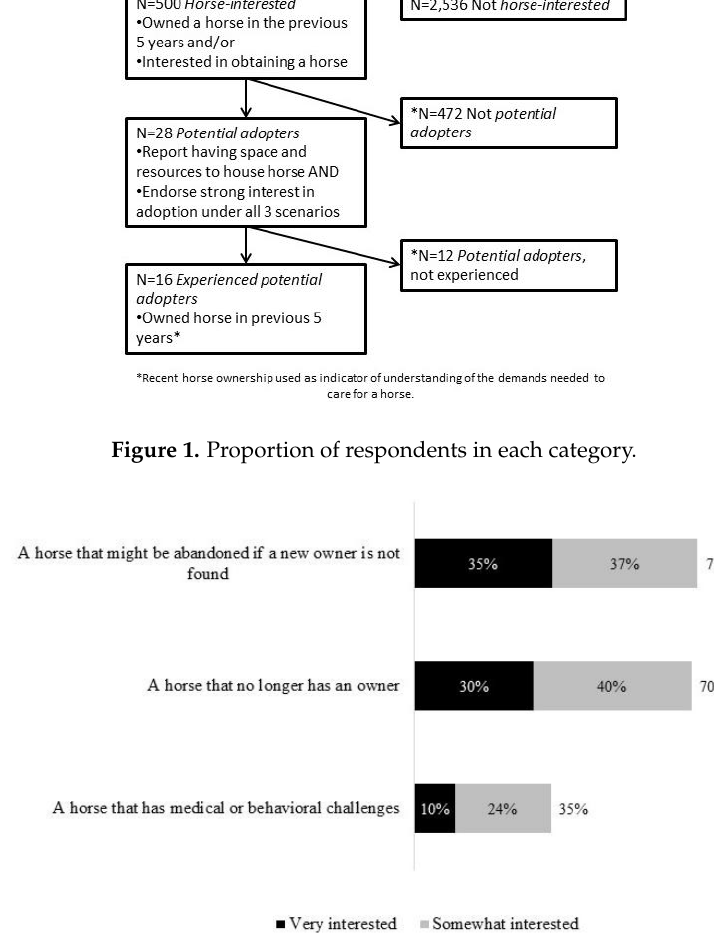
Figure 2. Reported interest by 500 horse-interested U.S. residents in adopting unwanted horses under various scenarios.